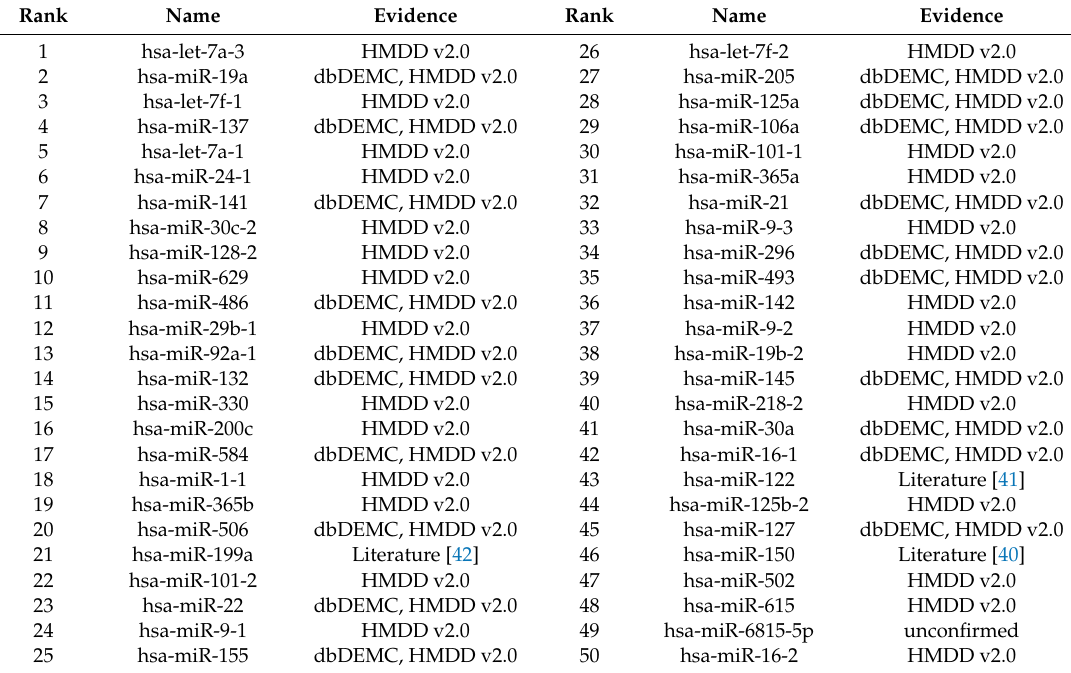
Table 2. Prediction of top 50 colon neoplasms candidates.